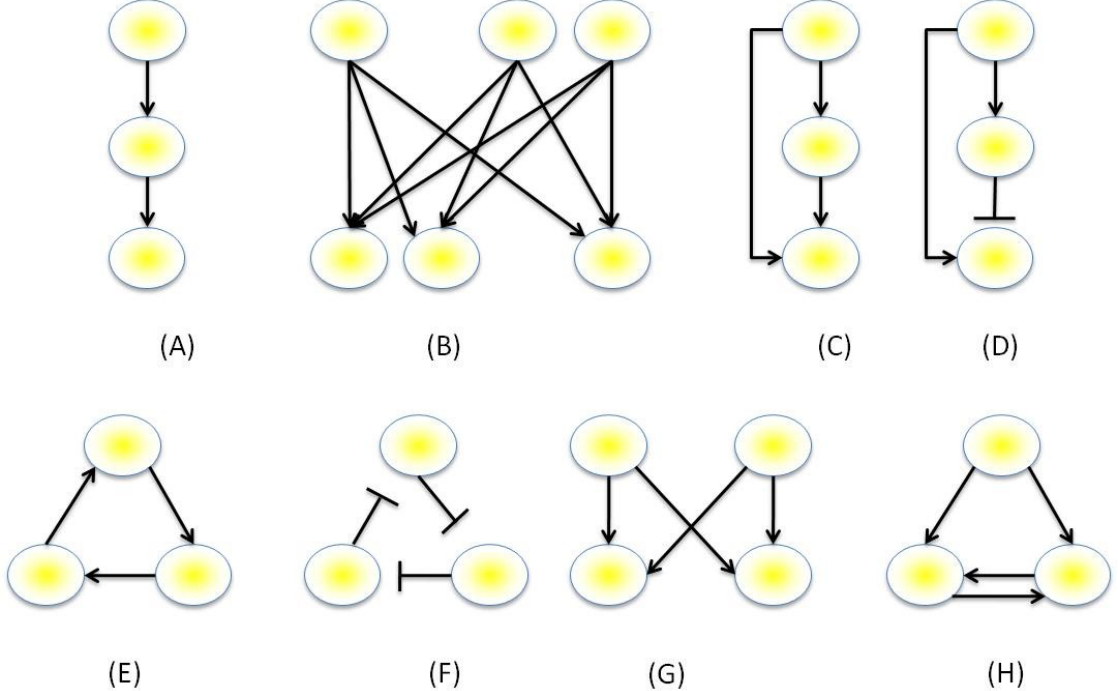
Figure 3. Example network motifs. ( A ) Single input module ( B ), multi-input module, ( C ) coherent feed-forward loop: The motif consists of a direct and an indirect pathway to activate the final gene. ( D ) Incoherent feed-forward loop: The overall sign of the indirect and direct paths differ. ( E ) Three-cycle positive feedback loop, ( F ) three-cycle negative feedback loop, ( F ) bi-fan motif, ( G ) double-positive feedback